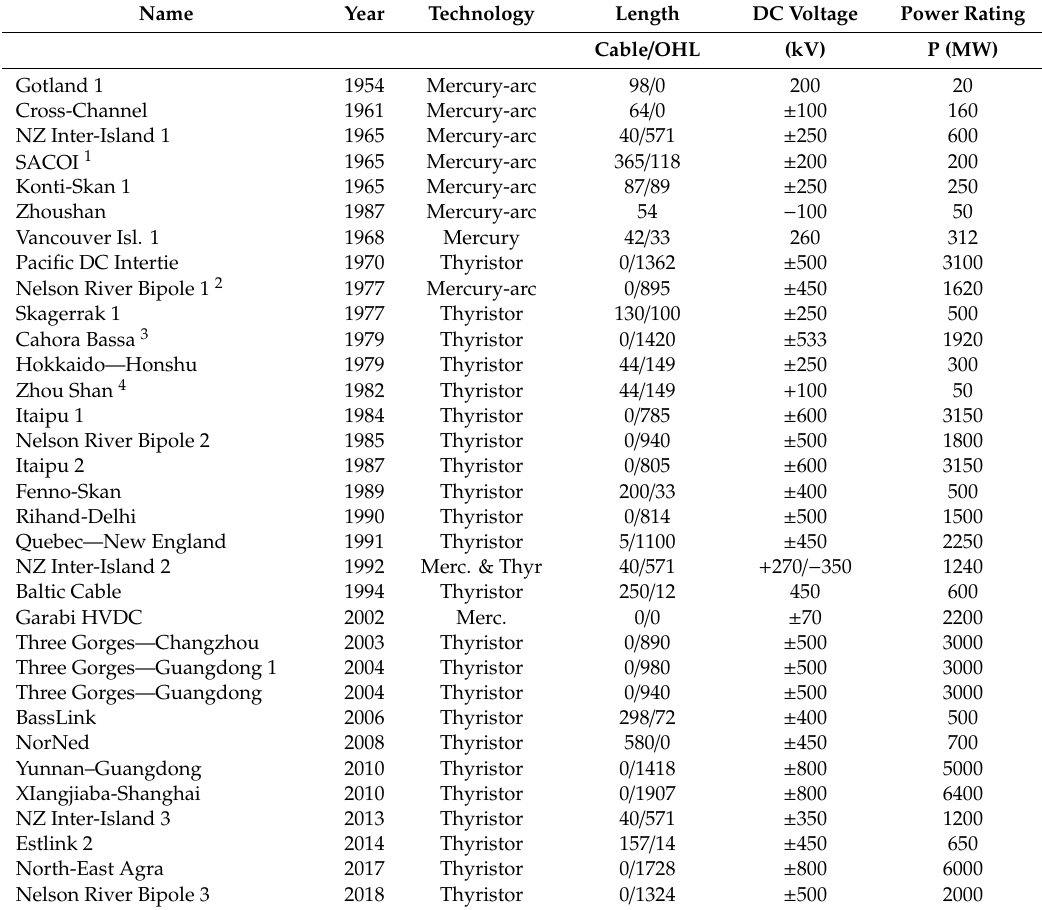
Table 2. Selected HVDC Schemes using Line-Commutated Converters